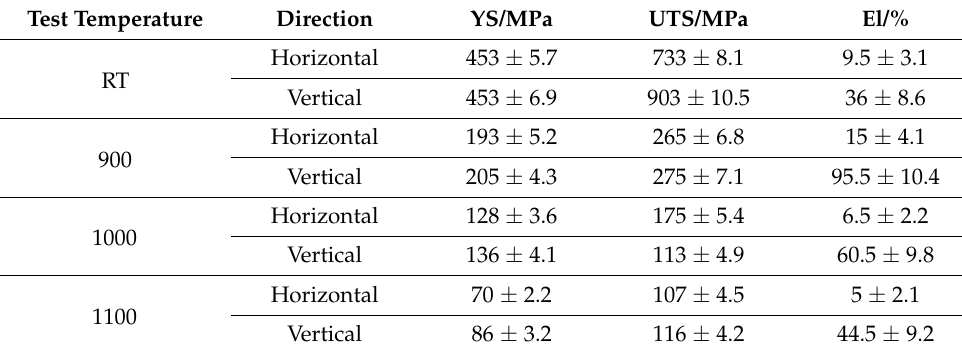
Table 3. The tensile properties of the